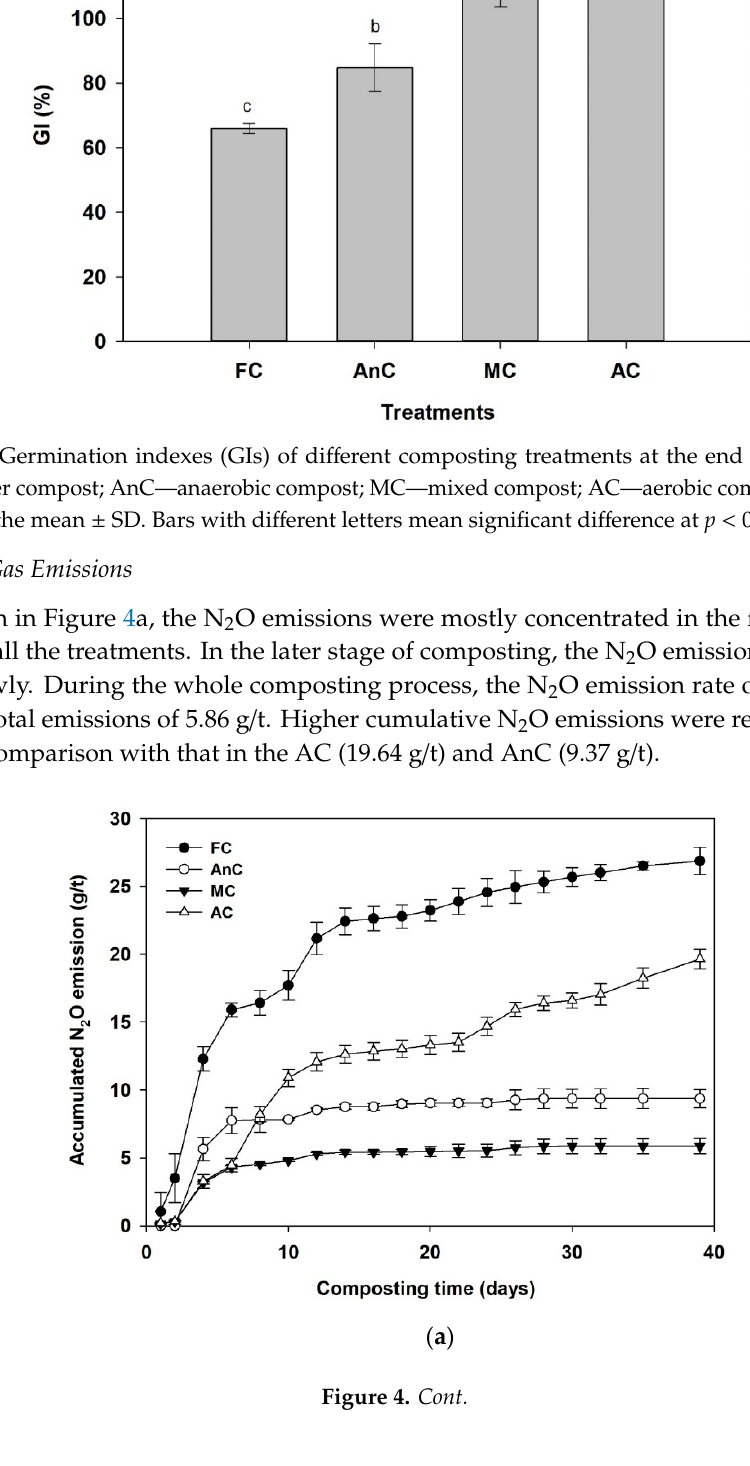
( b ) Figure 4. Accumulated gaseous emission of N 2 O ( a ) and NH 3 ( b ) during dairy manure composting. FC—farmer compost; AnC—anaerobic compost; MC—mixed compost; AC—aerobic compost.